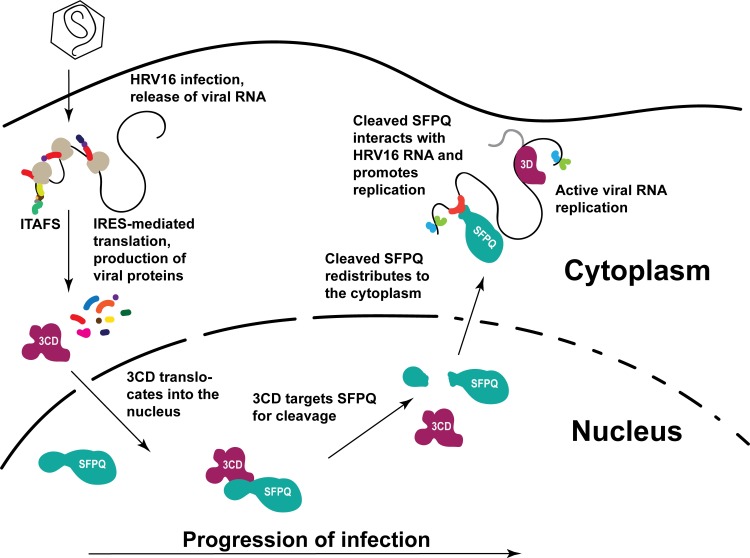
Proposed model of HRV16-SFPQ interactions during the infectious cycle.Following translation of viral proteins, HRV16 3CD/3C enters the nucleus where it targets SFPQ for cleavage at Q257 within the N-terminus. Cleavage releases SFPQ from interactions with nuclear-resident anchors such as DNA and allows the C-terminal fragment to migrate to the cytoplasm through degraded nuclear pore complexes. Once in the cytoplasm, the SFPQ fragment interacts with HRV16 RNA, directly or through other protein partners, and may promote viral replication.